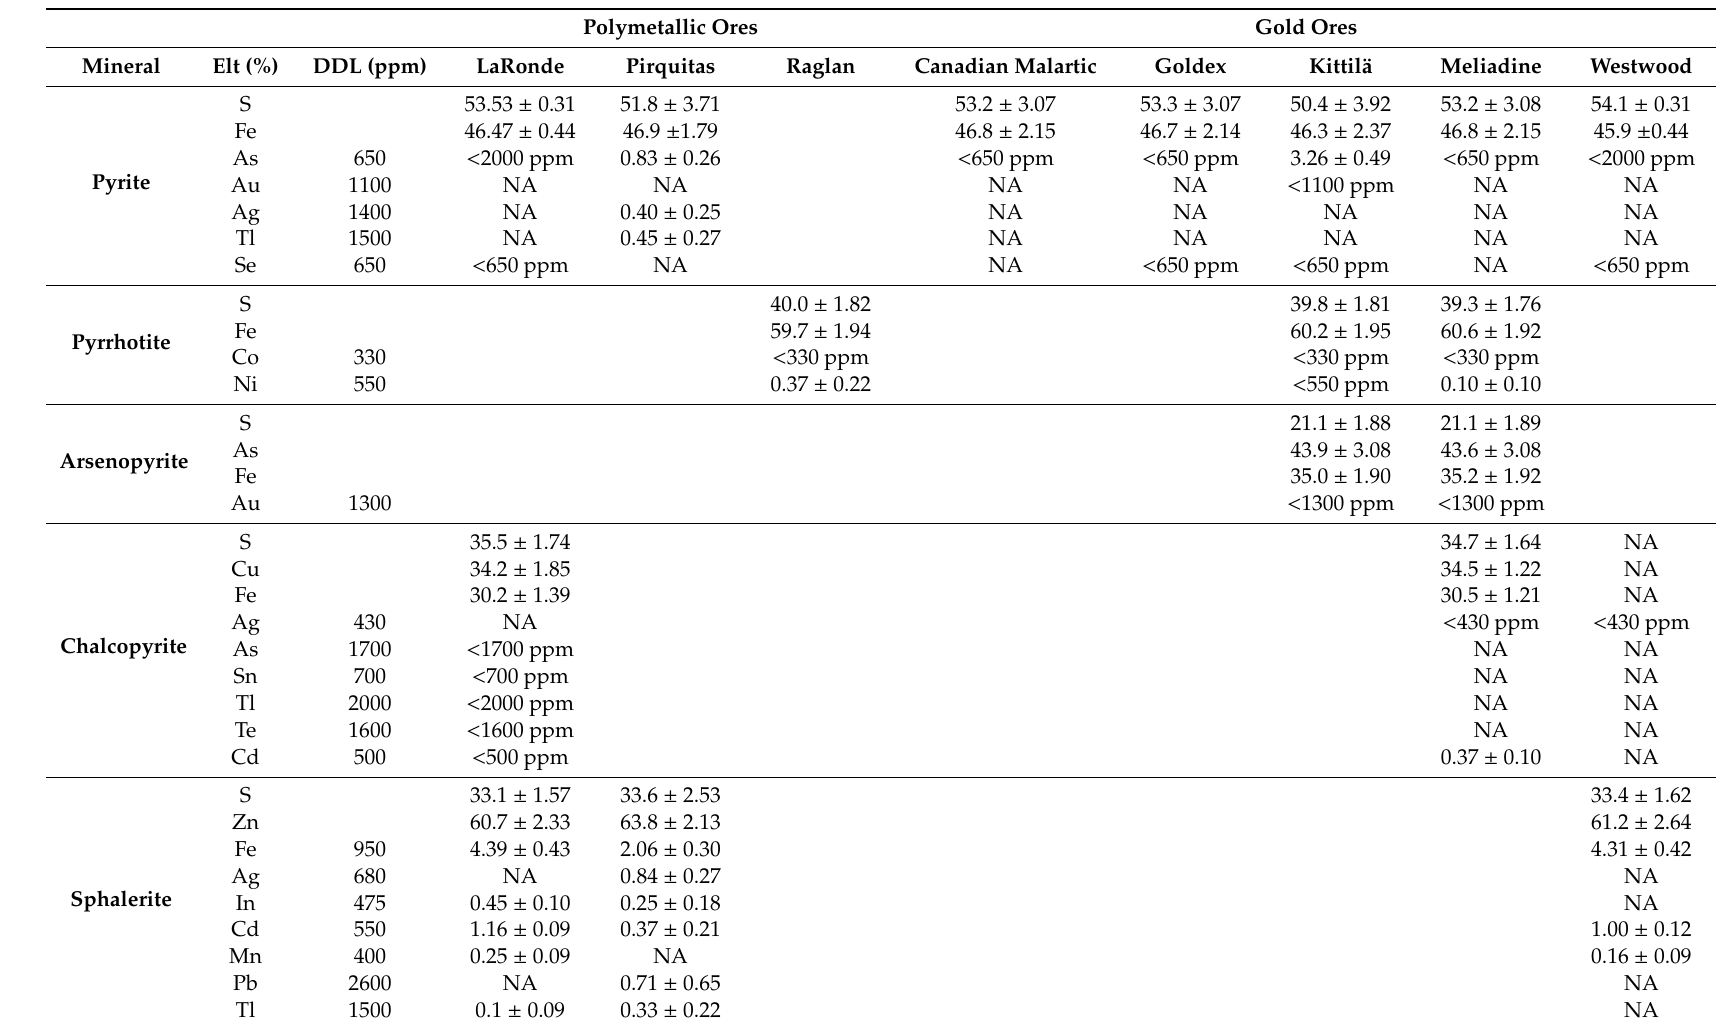
Table A4. EPMA analysis of the elements of interest in certain minerals